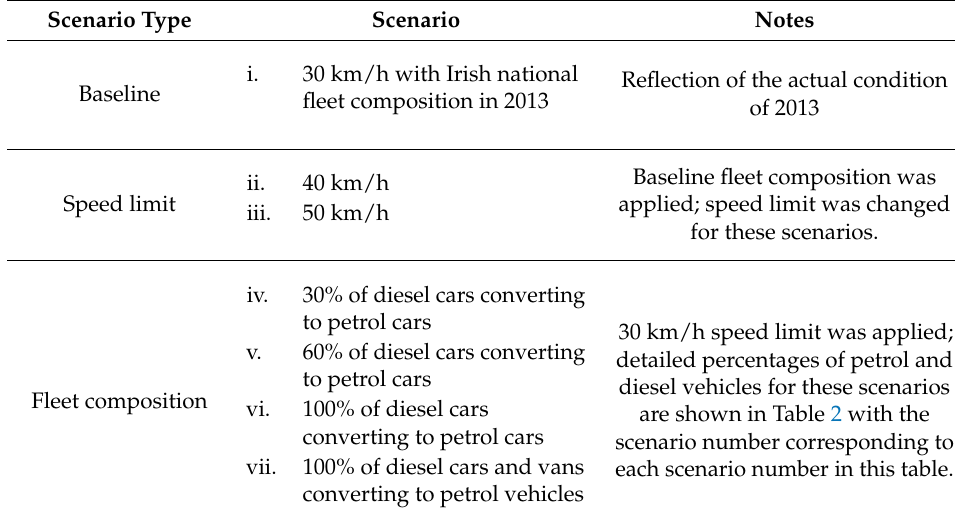
Table 4. Scenarios